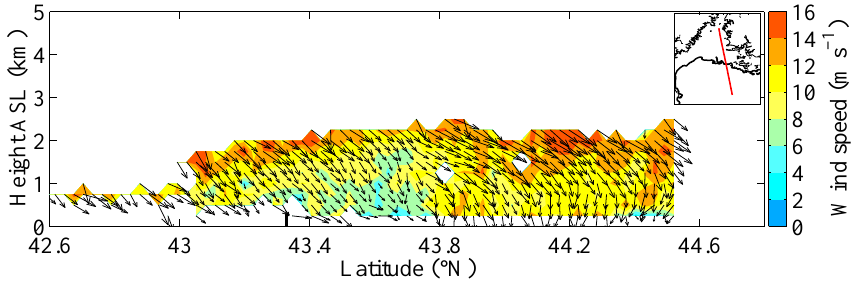
Fig. 4. Small rectangle: Topography of the ESCOMPTE area. The black lines indicate the 500-m isoline and the coastline. The red segments represent the flight track of the DLR Falcon 20 along which the vertical cross section of the horizontal wind field from the WIND data is extracted and shown in the main panel. Main figure: Vertical cross section of the horizontal wind field from the WIND data along the leg shown in the small subpanel on 22 June 2001 at about 17:00 UTC (the time of the entire DLR Falcon 20 flight is given in Table 1). Arrows indicate the horizontal wind speed and direction as a function of height. A northerly wind is a vector aligned with the vertical axis directed downward. The color code indicates the wind speed. The absence of data corresponds to discarded unreliable data flagged using the quality control procedure by Dabas et al. (1999). The dark thick tick indicates the location of the coast. On that leg, the coastline is at about 43.33 ◦ N.